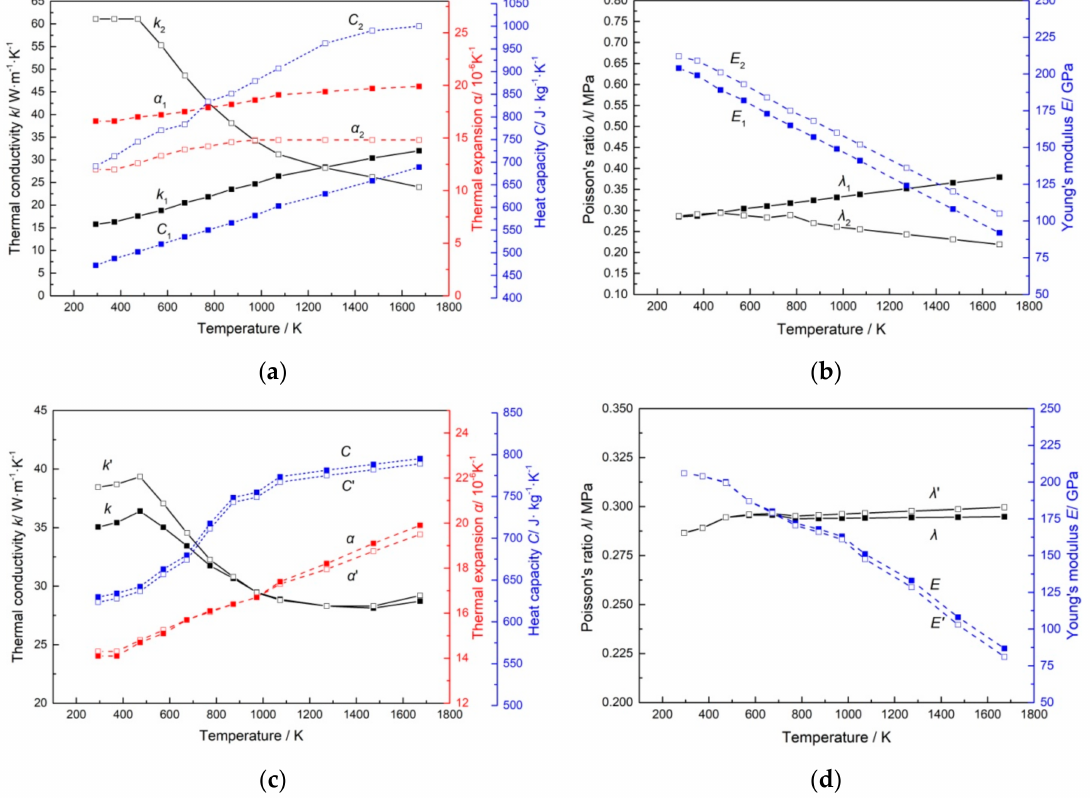
Figure 5. Material properties of the SCLP: ( a ) Thermodynamic properties of stainless steel and carbon steel; ( b ) Mechanical properties of stainless steel and carbon steel; (c ) Comparison of thermodynamic properties of transition layer between the two calculation methods; ( d ) Comparison of mechanical properties of transition layer between the two calculation